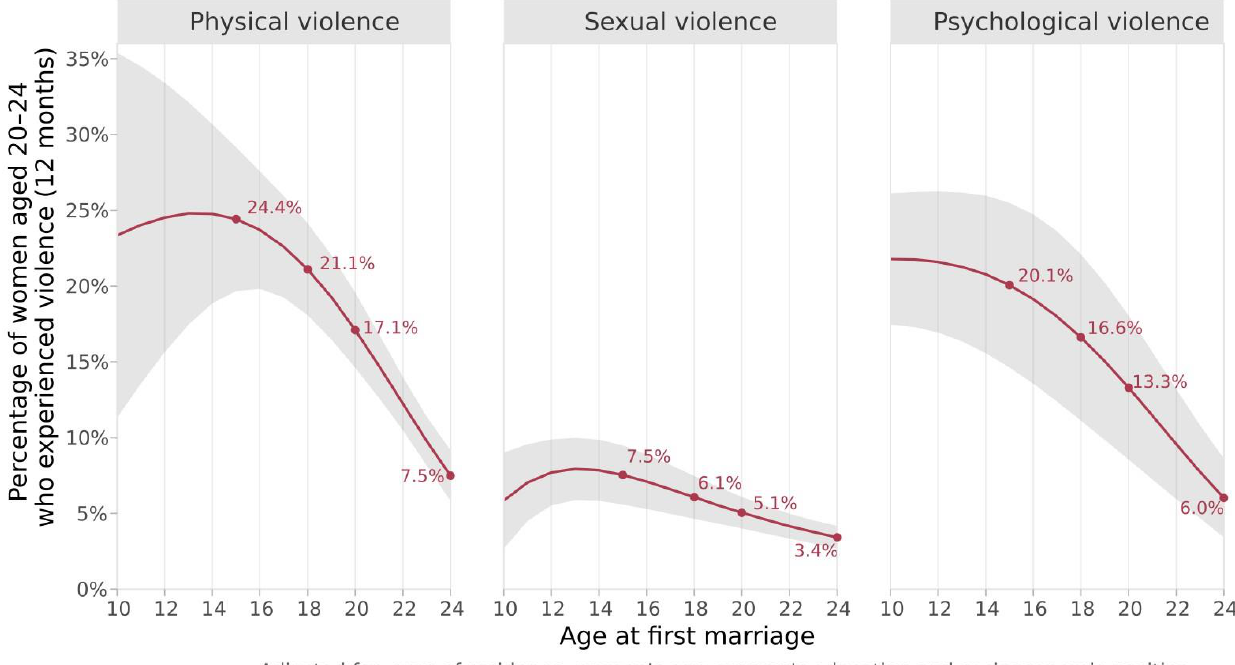
Figure 1. Average adjusted past year IPV prevalence according to age at first marriage for women aged 20 to 24 years. Pooled results for 48 low- and middle-income countries obtained from a multilevel logistic regression model. The red line represents the continuous IPV estimate from ages 10 to 24 years at first marriage. The grey area represents the respective confidence interval. IPV estimates for the ages 15, 18, 20, and 24 years are highlighted.